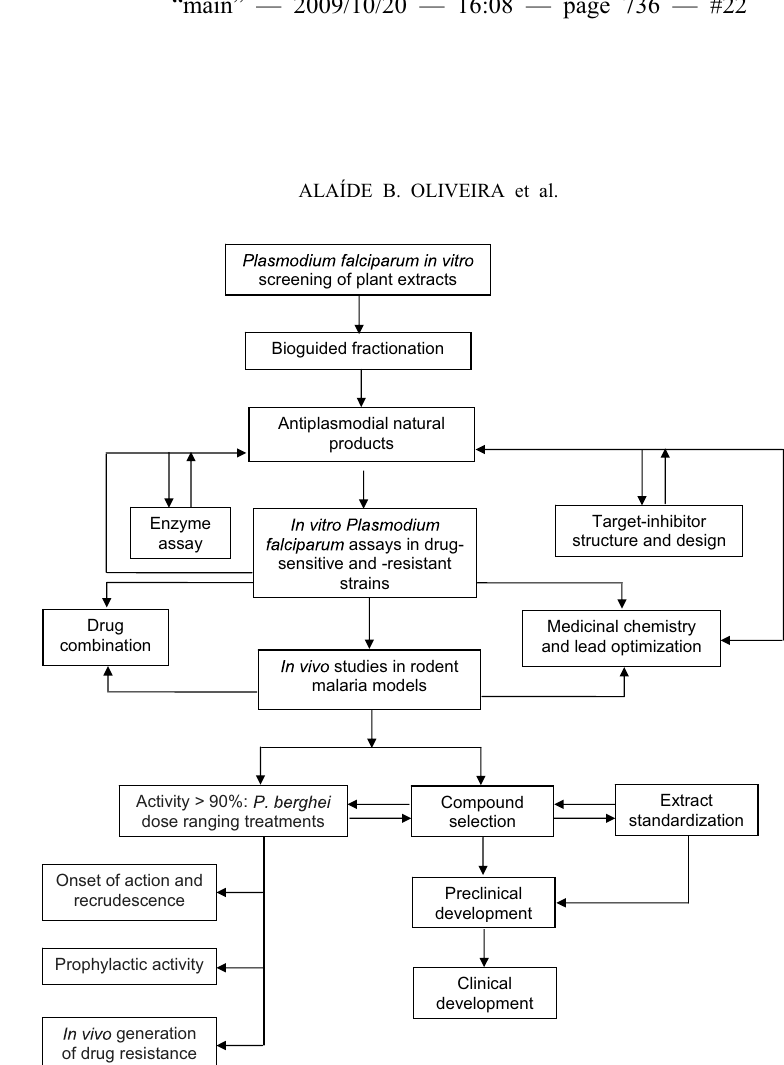
Fig. 2 – General approach for antimalarial drug discovery and phytomedicines development (adapted from Fidock et al. 2004). Discovery starts with Plasmodium falciparum in vitro screening of plant extracts, followed by bioguided fractionation of active extracts, resulting in the isolation of antiplasmodial compounds. At this stage, active target enzymes can be employed in biochemical screens, which may well support molecular modeling and design of potential active compounds, based on target-inhibitor interactions. In vitro assays comprise determination of IC 50 against sensitive and resistant strains of Plasmodium falciparum and such results may allow selecting templates for chemical optimization. In vivo assays include tests for suppression of parasitaemia in rodents. In combination, in vitro and in vivo studies are directed towards template